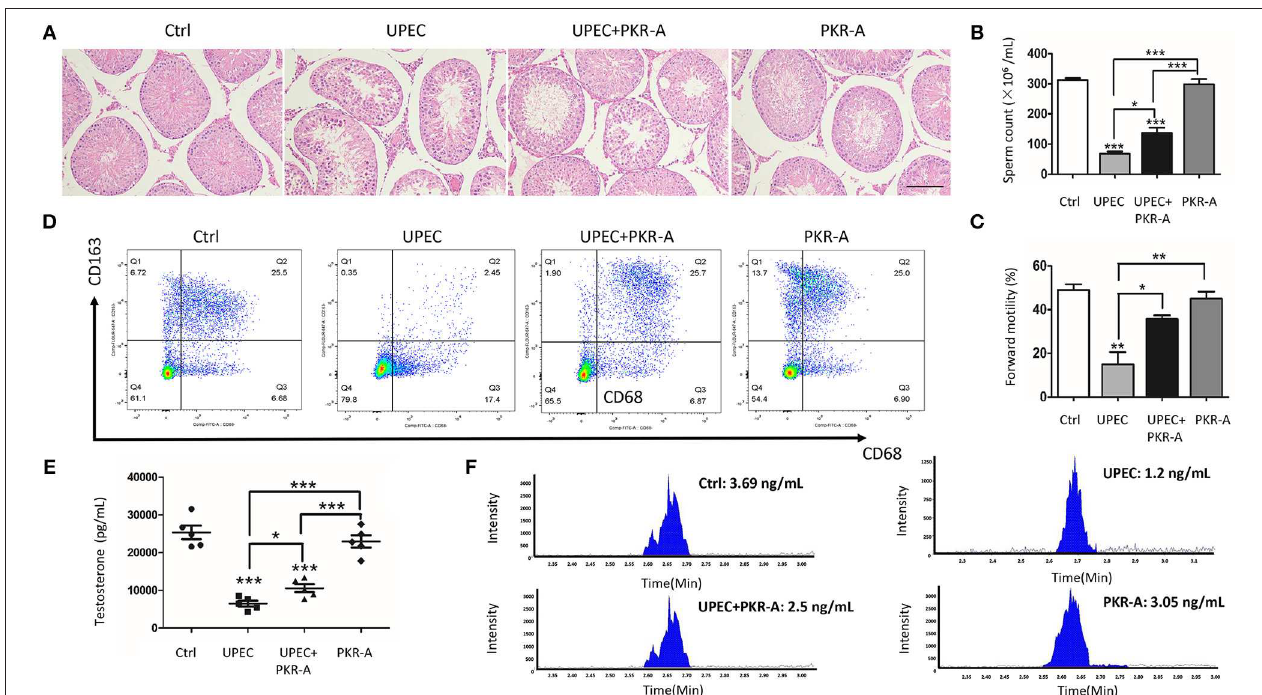
FIGURE 2 | PK2 impairs testicular histological structure, testosterone synthesis, and semen quality. The UPEC-infected rats were injected with either 20 mg/kg of PKR-A or 5% DMSO into the testes every 2 days during the experiment. The sham operated rats received 5% DMSO and the rats were treated with PKR-A alone as a control. (A) Testicular histological changes were detected by H&E staining ( n = 5/group). (B) Sperm count was analyzed ( n = 5/group). (C) Sperm forward motility was analyzed ( n = 5/group). (D) In the flow cytometry examination, the total leukocyte population of testicular interstitial cells was marked by the expression of CD45, and gated for the identification of rat macrophage subsets by the surface markers of CD68 with or without CD163( n = 5/group). (E) The testosterone level in the serum was detected by chemiluminescent immunoassay ( n = 5/group). (F) The testosterone level in the serum was detected by LC-MS. Scale bar 100 µ m. Ctrl, control. * P < 0.05, ** P < 0.01, *** P < 0.001 (one-way